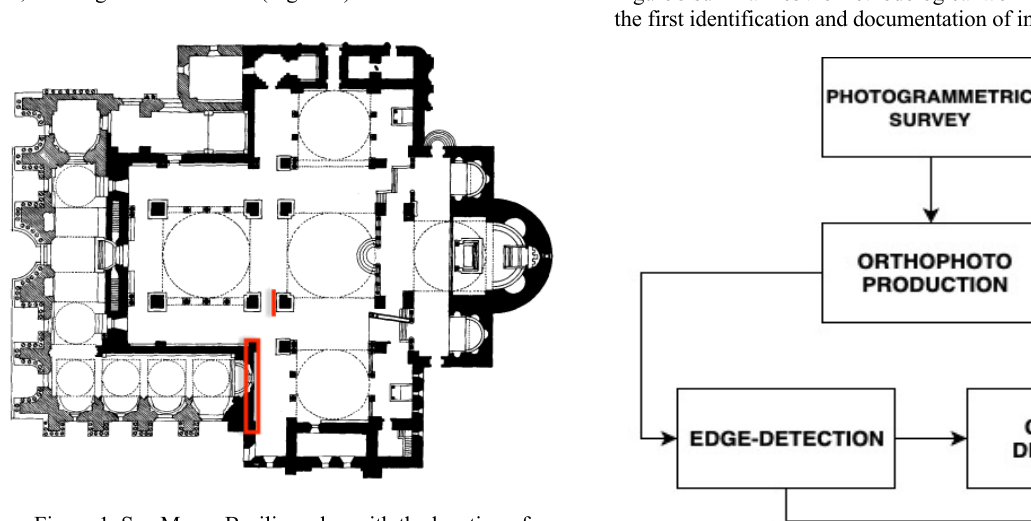
Figure 1. San Marco Basilica, plan with the location of analysed areas.